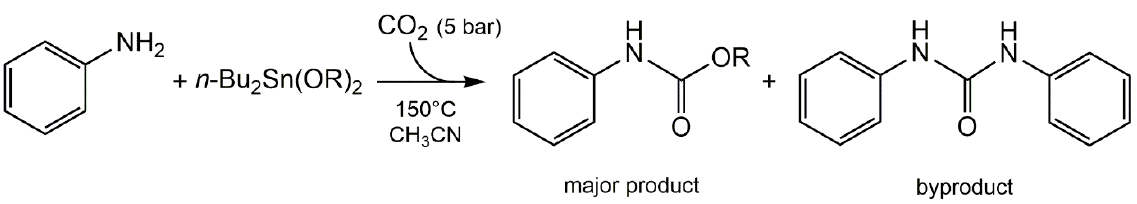
Scheme 6. Tin-promoted synthesis of N -phenyl carbamate from aniline and carbon dioxide (R = Me, Et, n -Pr, and n -Bu), data from [30].